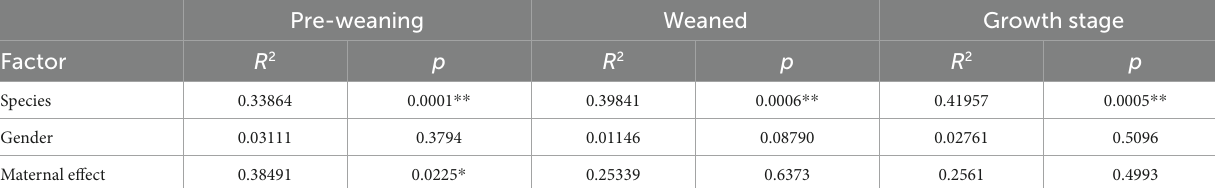
TABLE 2 Andonis results of the metabolome.